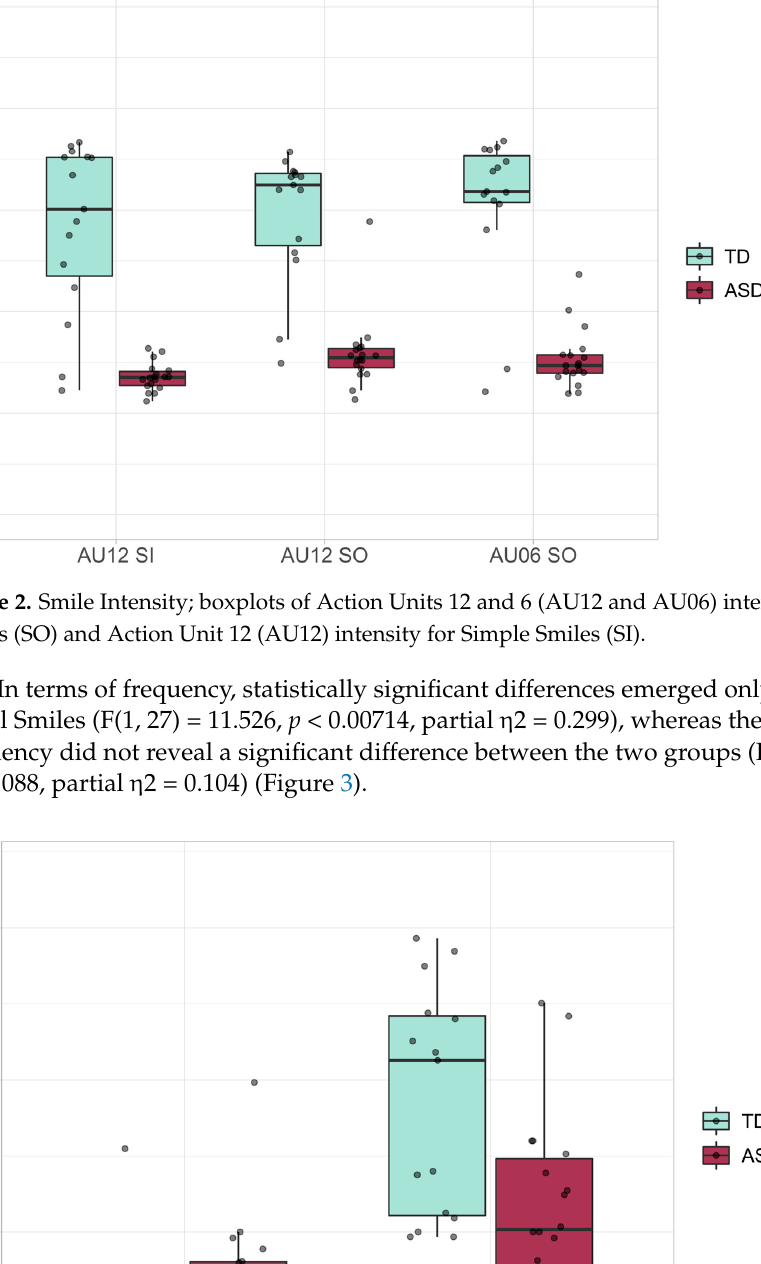
Figure 3. Smile Frequency; boxplots of the average frequency for Simple (SI) and Social (SO) Smiles in ASD and TD groups. Frequency is expressed in terms of the number of expressions over 120 s of interaction.